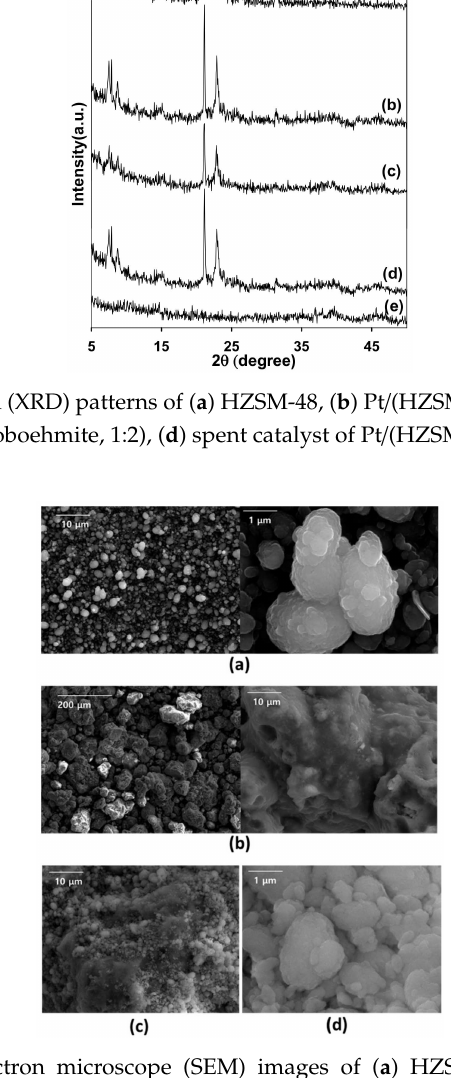
Figure 2. ( c ) Pt / (HZSM-48 + pseudoboehmite, 1:1), ( d ) the portion corresponding to Pt / HZSM-48 from ( c